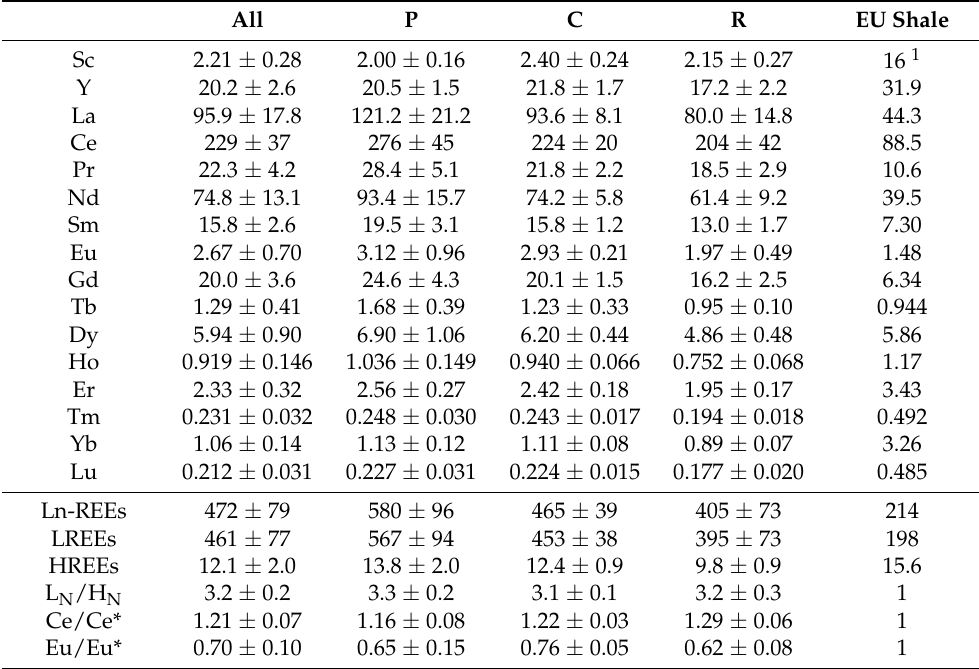
Table 1. Summarized REE contents (mg kg − 1 ) in the studied sediments. All correspond to the complete datasets (statistics after deleting outliers), P are surface sediments trapped into rock cavities, C is the depth core trapped into a pothole, and R are untrapped sediments in the riverbanks. The EU shale are the reference contents from